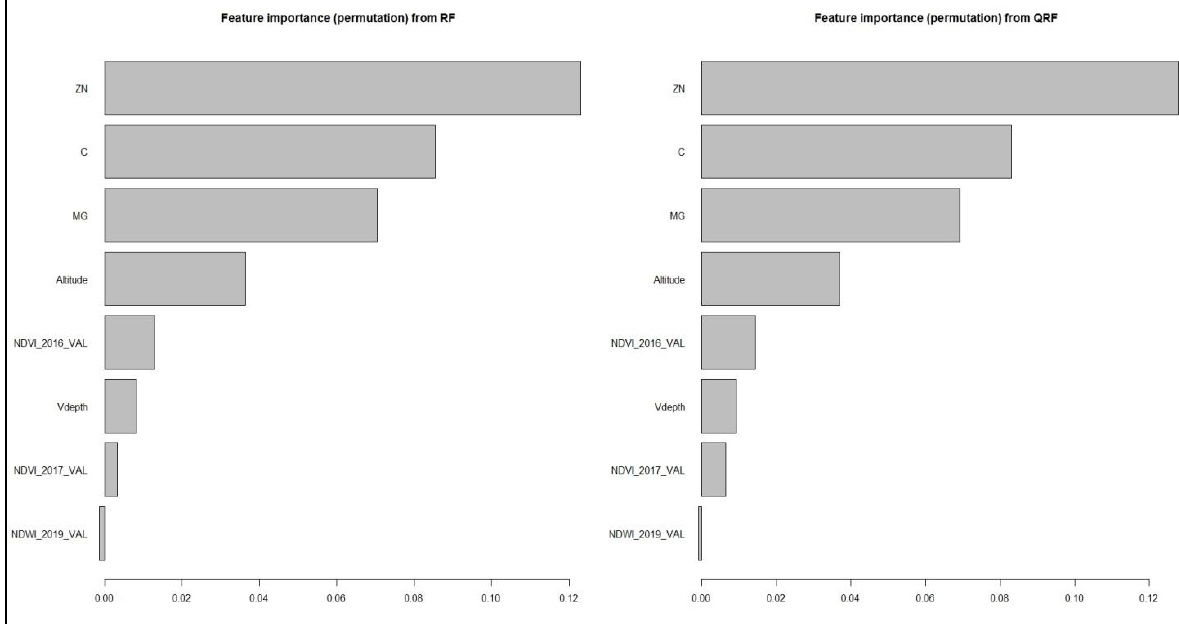
Table 6. Prediction results for soil